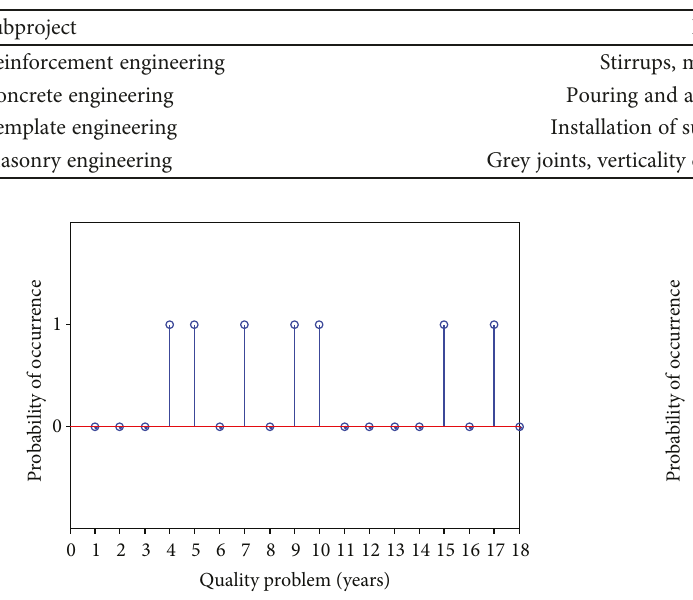
Table 6: Frequent-point statistics of quality problems.